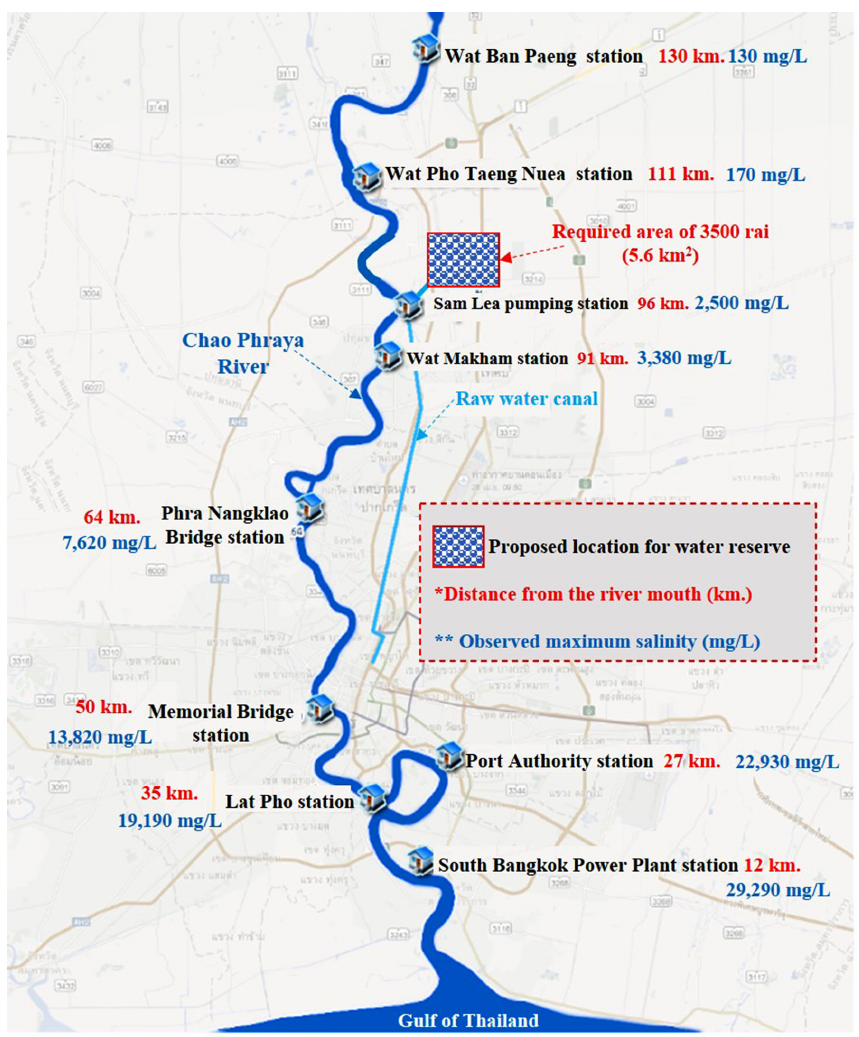
Fig. 8. Option 2: proposed location for the water reservoir during the seawater intrusion period. creased 0.01 baht/m 3